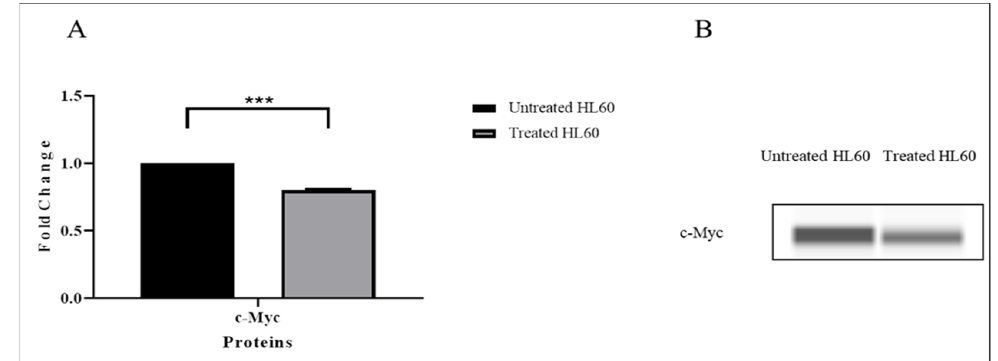
Figure 10. Effects of TQ on the expression of c-Myc protein in HL60 cells. ( A ) c-Myc protein expression in TQ-treated cells compared with untreated cells or negative control. Data are presented as the mean ± SEM (*** p < 0.001). ( B ) Image of c-Myc protein expression from capillary Western blotting in treated and untreated HL60 cells.